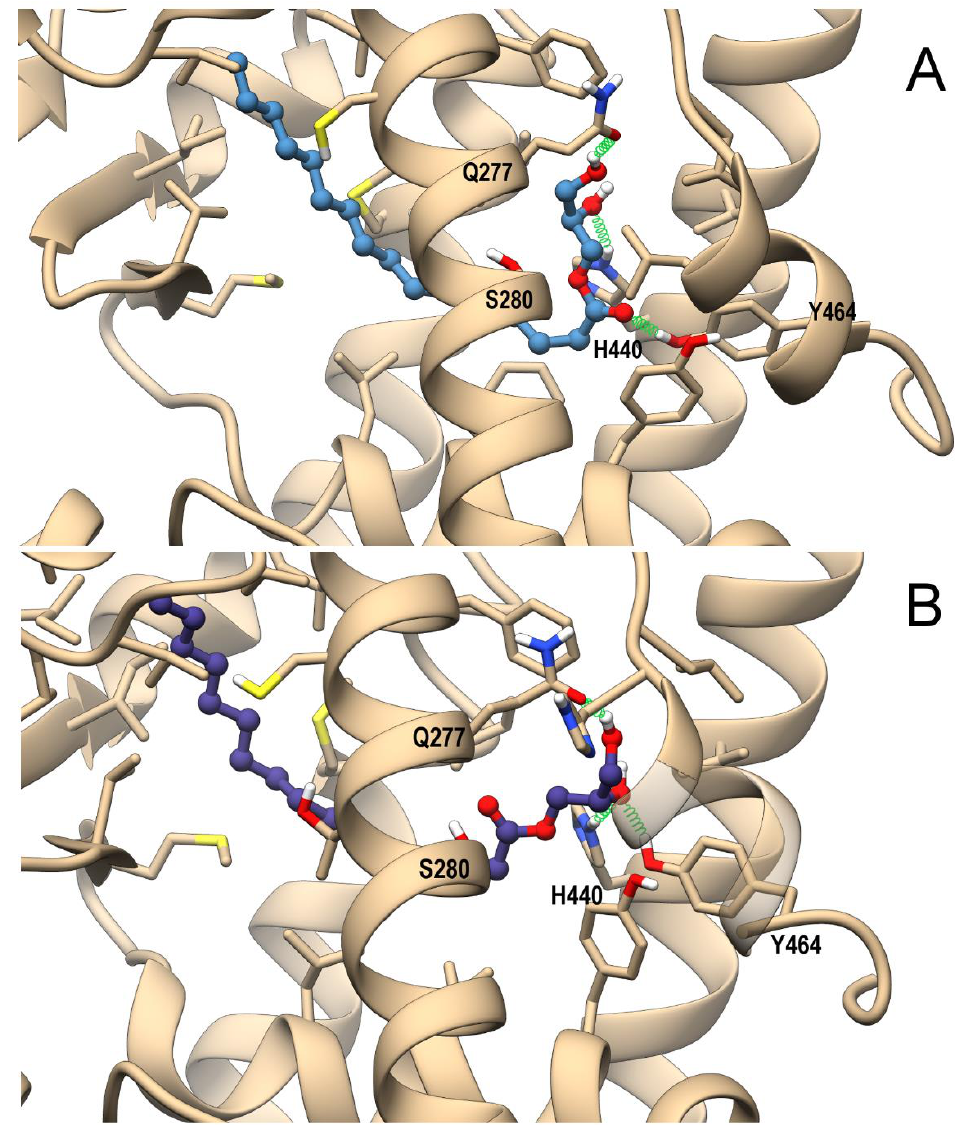
Figure 6. Theoretical complexes of PPARα (tan) with D-PG (steel blue) ( A ) and L-PG (slate blue) ( B ) with 1-PG shown in ball & stick representation. Protein residues within 5 Å from the ligands are shown in stick representation. H-bonds are shown as green springs. Hydrogen, nitrogen, oxygen, and sulfur atom are painted white, blue, red, and yellow, respectively. A transparent surface for ribbons was used wherever they hide the ligand-binding site.